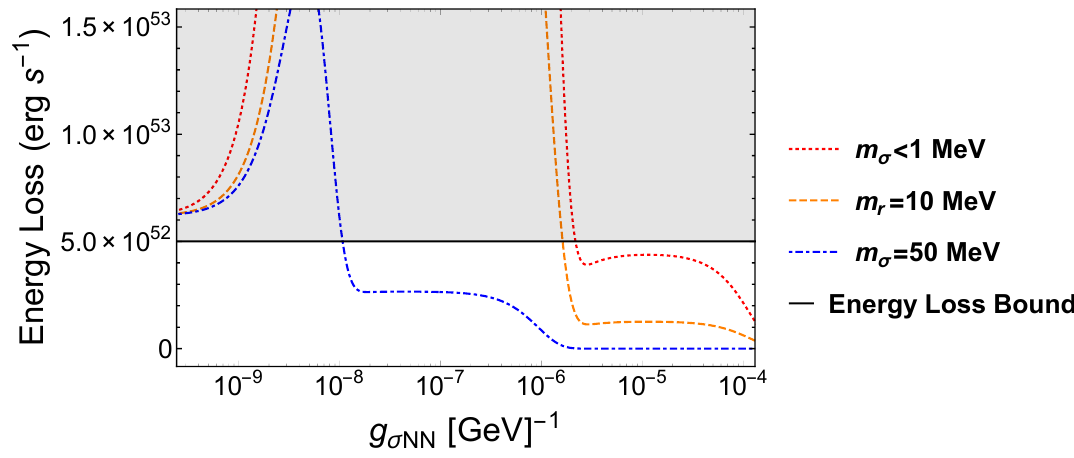
Figure 4. The energy loss rate via radions with g (cid:27)(cid:13)(cid:13) = 2 (cid:2) 10 (cid:0) 9 GeV (cid:0) 1 . See details in the text. The red-dotted line represents the radion mass m (cid:27) , of 1 MeV, the orange-dashed m (cid:27) = 10 MeV, the blue-dot-dashed m (cid:27) = 50 MeV and the solid black horizontal line marks the bound, (5.1).